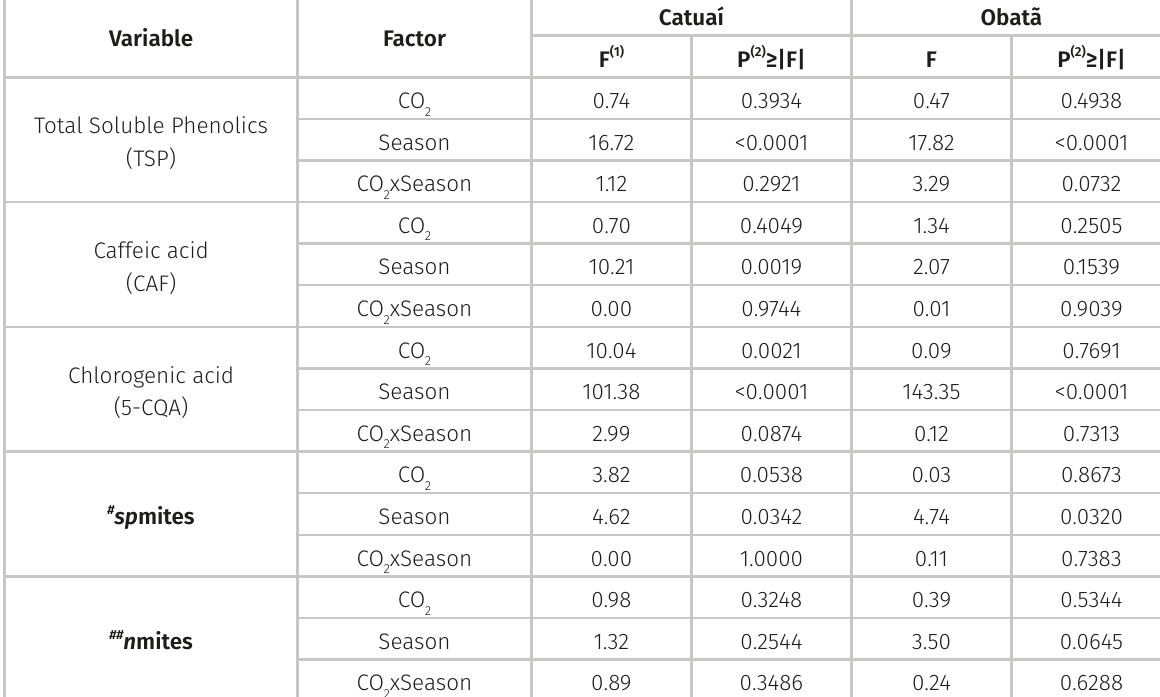
] (elevated/ambient), in two seasons (dry/rainy) under factorial 2